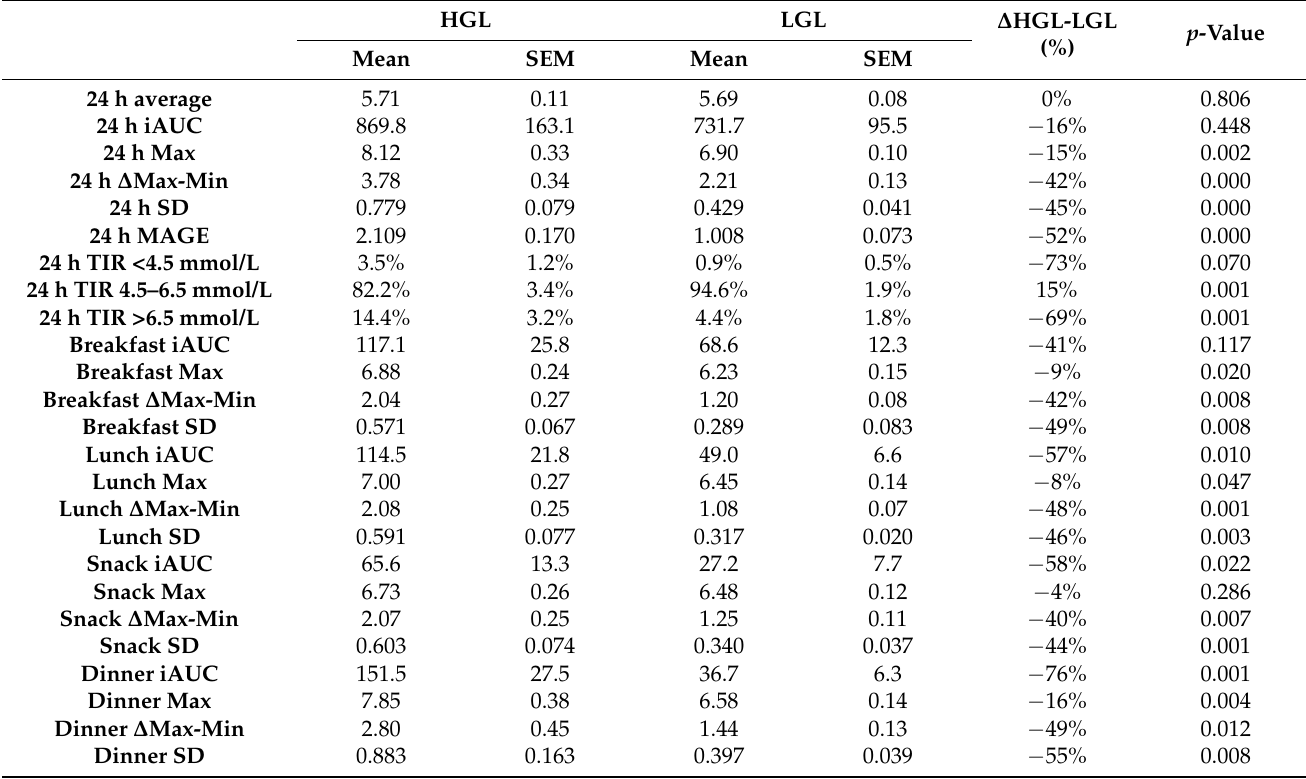
Figure 1. Change in 24 h glycemic response over time for the LGL and HGL diet. LGL: reduced GL; HGL: high GL. Table 4. Glycemic parameters for the LGL and HGL 24 h